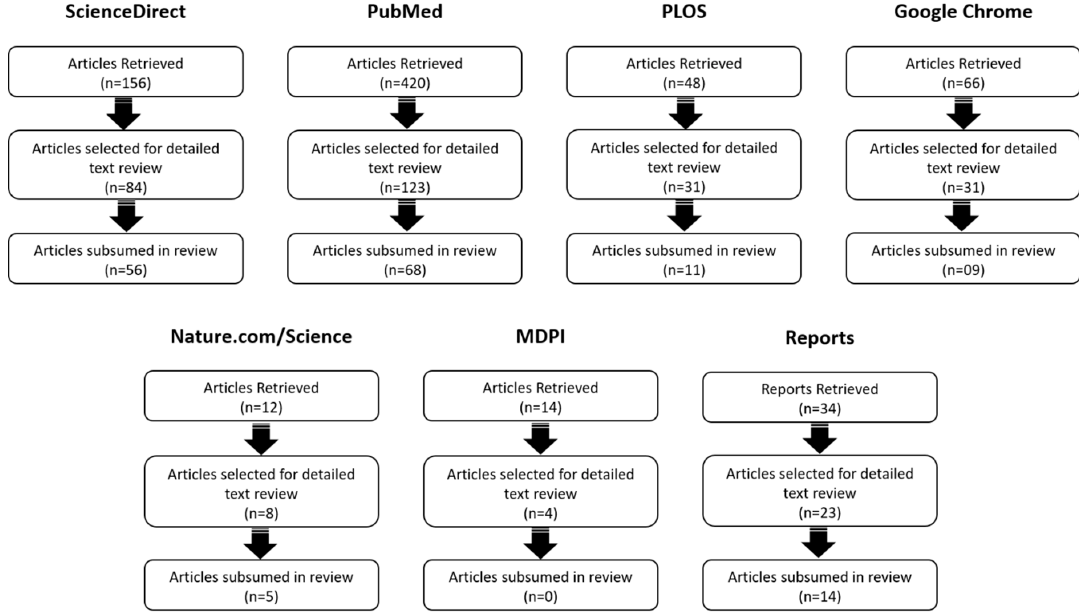
Figure 2. Illustration of the article-screening process across databases: Articles retrieved, articles selected for detailed text review, and articles subsumed in review (where n denotes the number of articles/reports).